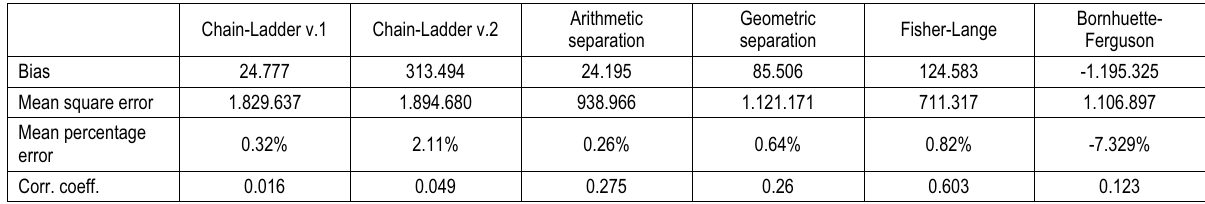
Table 9. Method of single